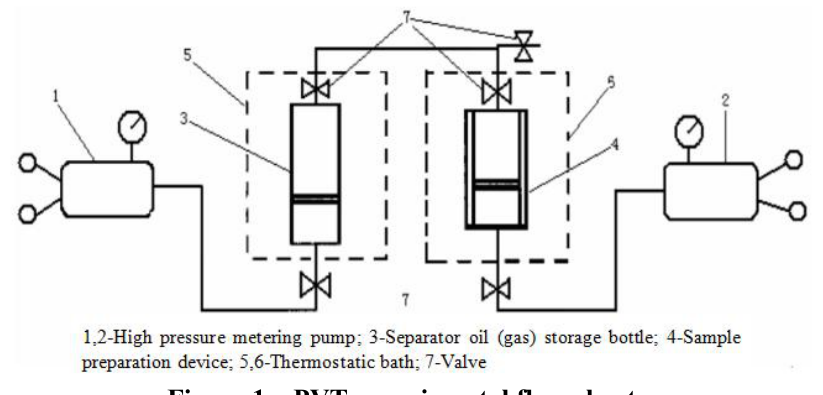
Figure 1—PVT experimental flow